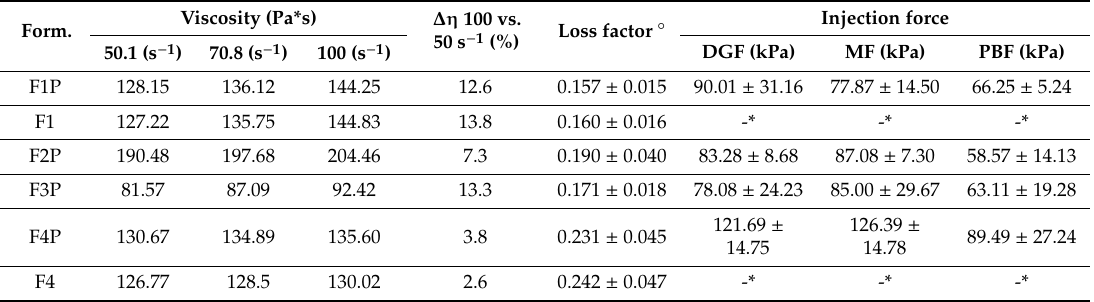
Figure 4. Plots of log ω versus log G ″ of XG and XG:GG mixtures.